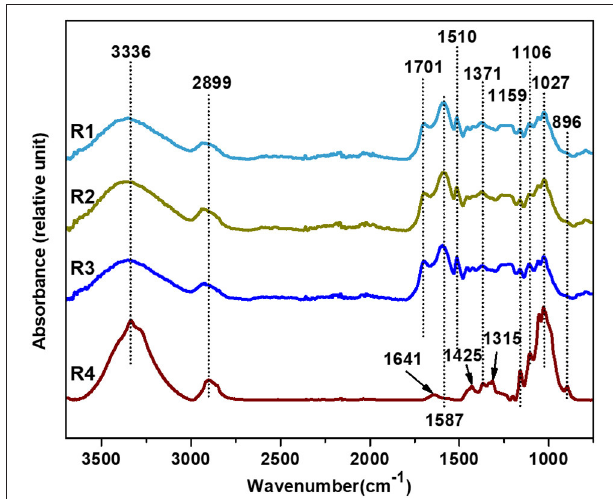
FIGURE 6 | FT-IR spectra of the alkali treated furfural residue.